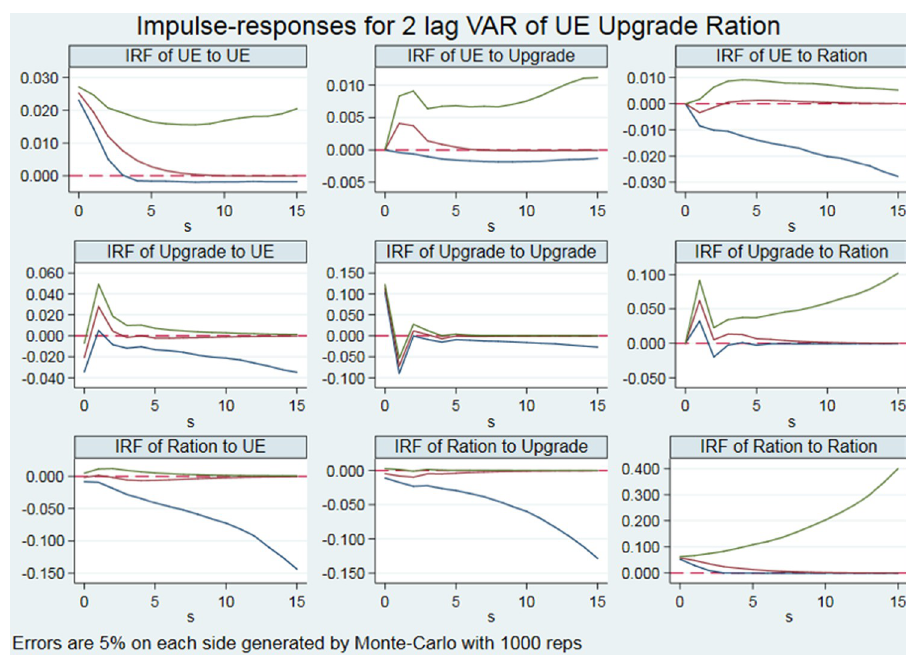
Fig 3. Impulse response results of robustness test.